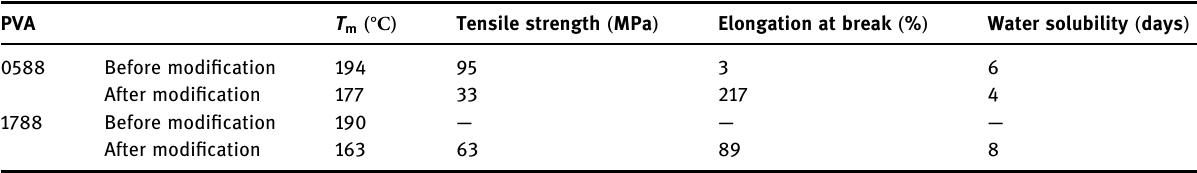
Table 2: Properties of PVA0588 before and after modi fi cation ( 37 ) PVA